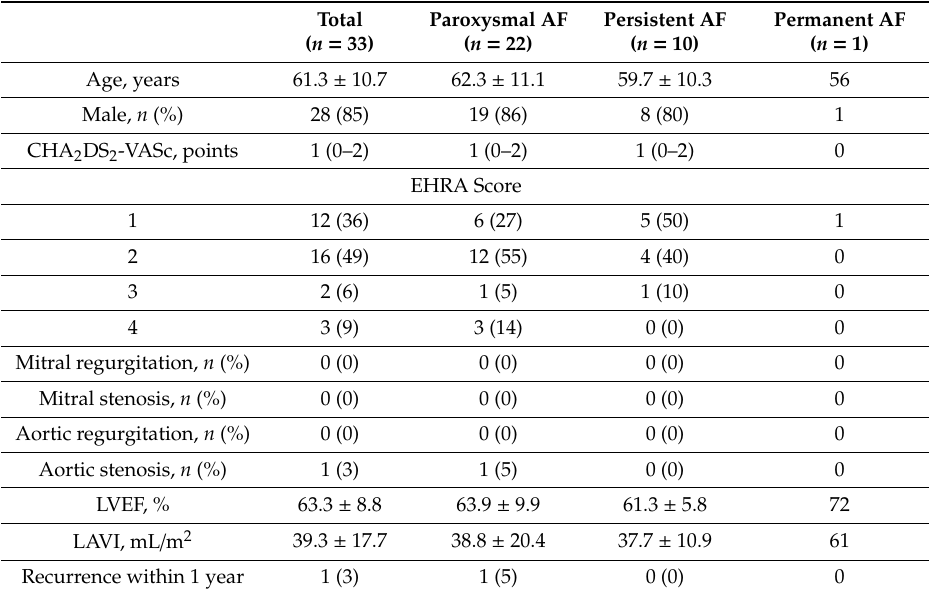
Table 2. Characteristics of patients who underwent catheter ablation.